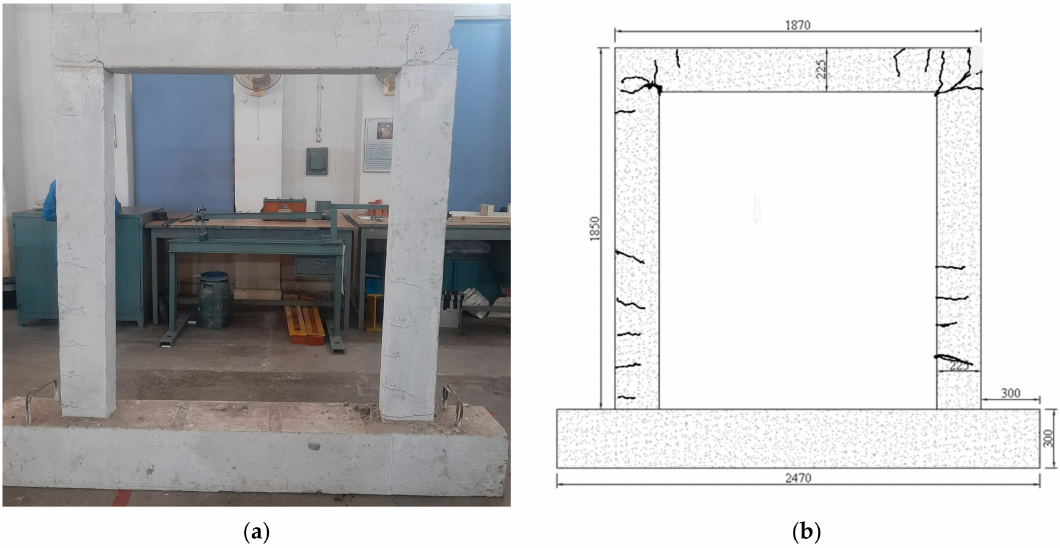
Figure 12. Crack pattern of OPC-BF ( a ) failure pattern of actual sample, ( b ) crack pattern